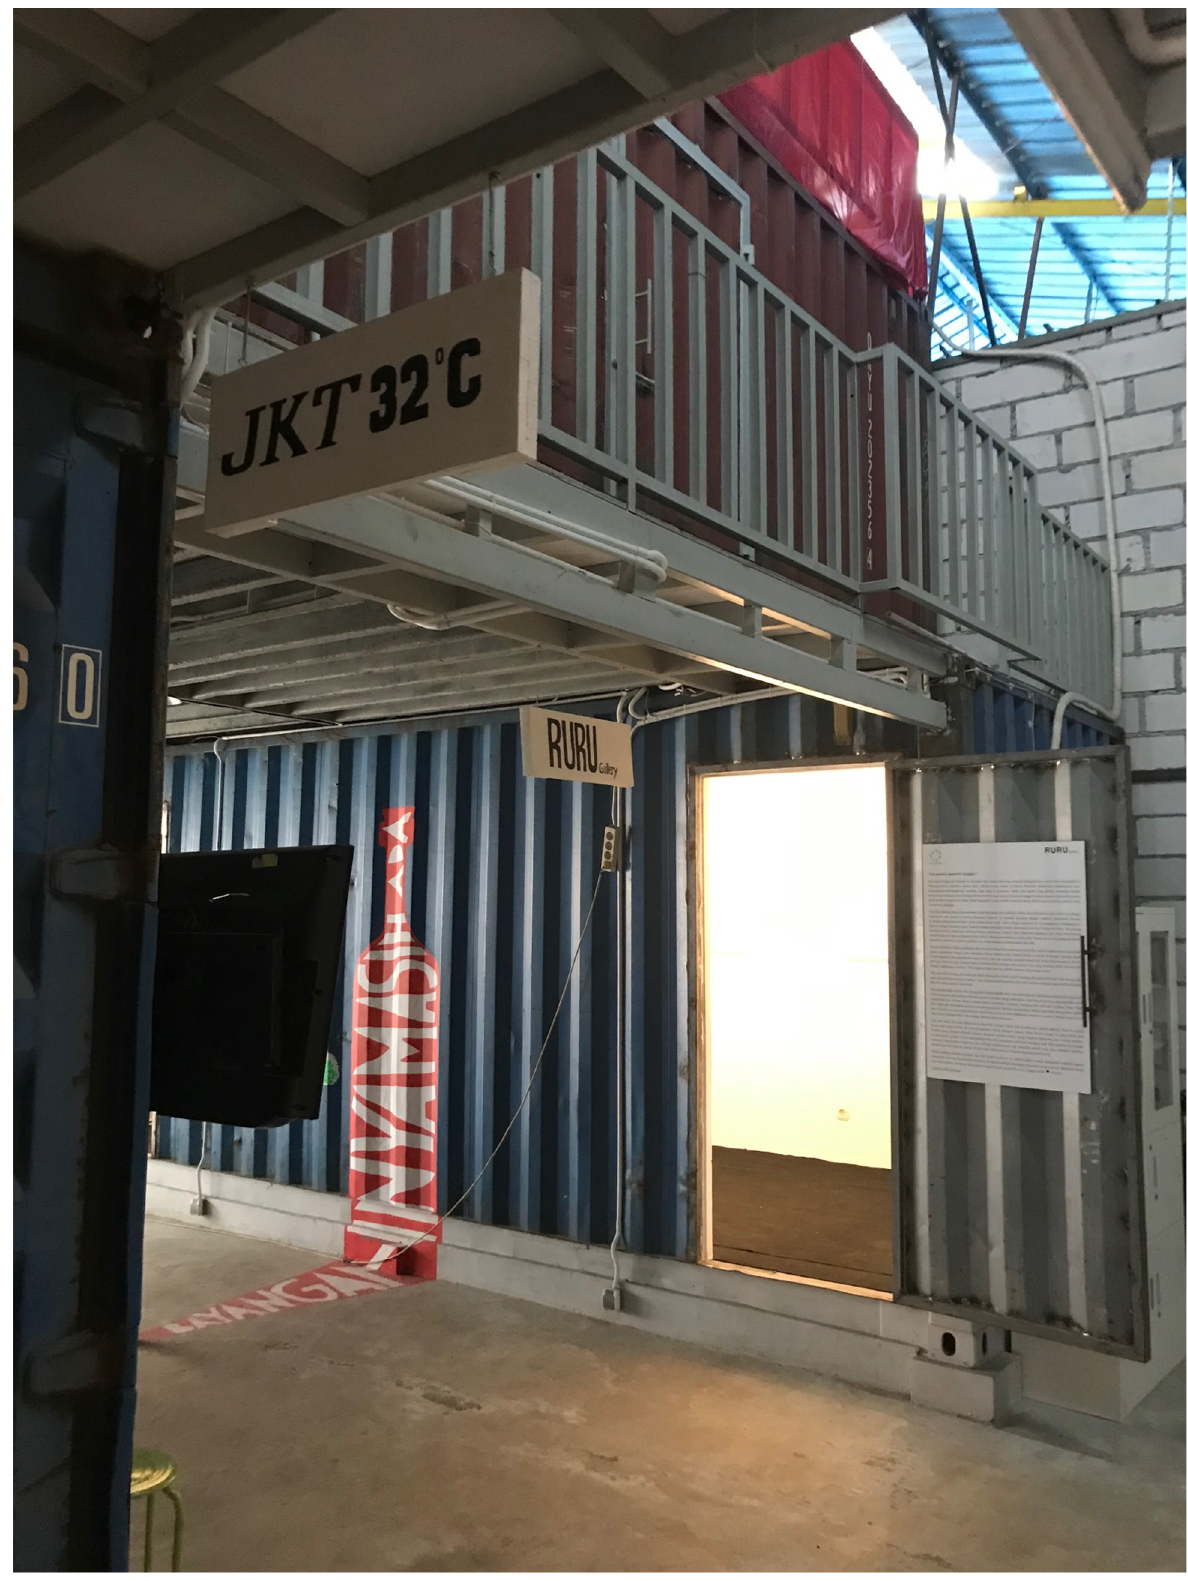
Figure 4. Gudskul, 2019. Image courtesy of the author.